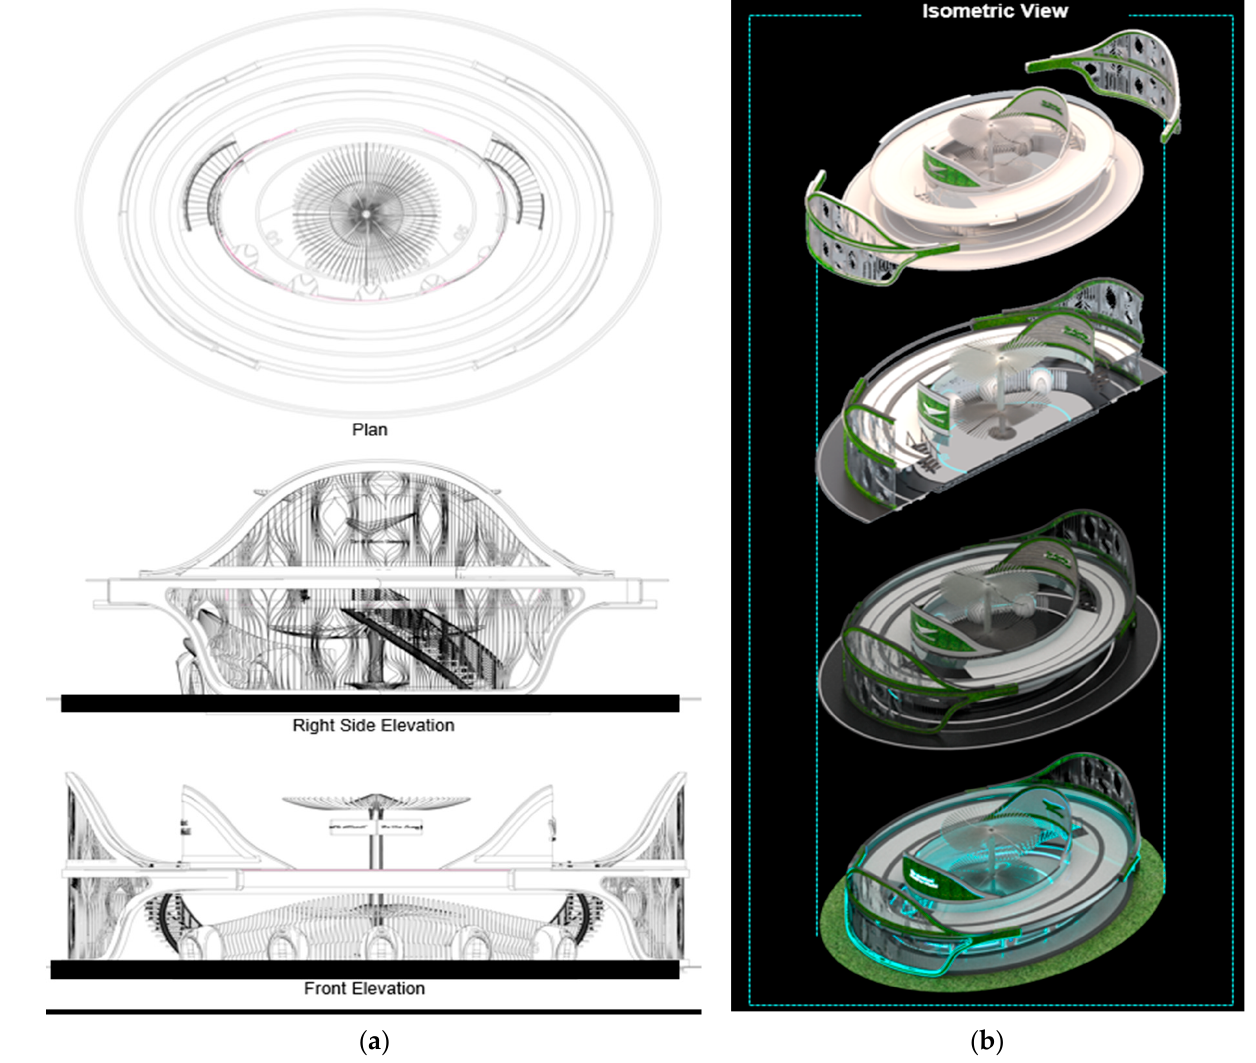
Figure 15. ( a ) Plan showing the right side and front elevation for the double floor walking track; ( b ) different isometric views (designed by the authors).